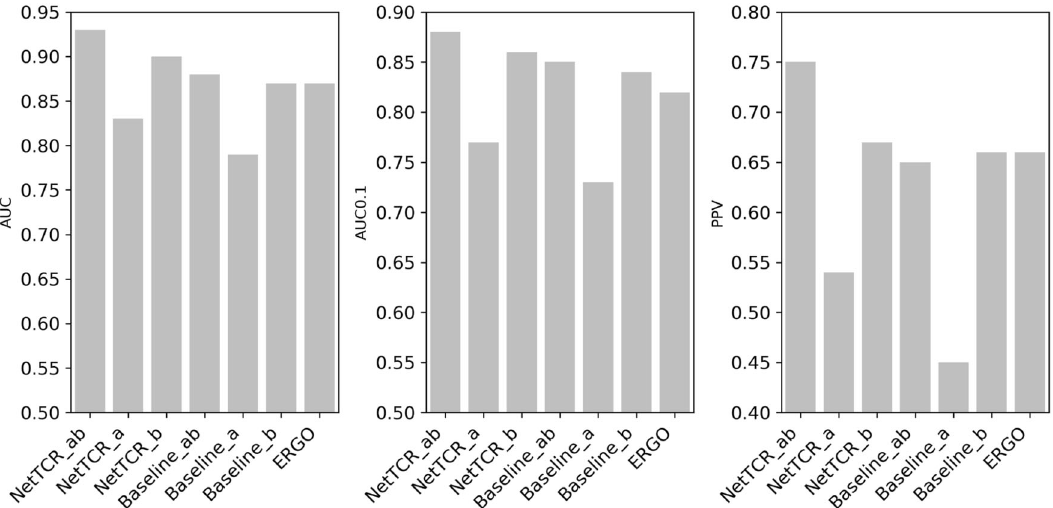
Fig. 8 Benchmark performance on in-house TCR data set. Methods included are NetTCR and baseline trained on paired CDR3 α – CDR3 β data (ab), CDR3 α (a), CDR3 β (b), and the LSTM-based ERGO trained on the VDJdb. Performance measures are (left) AUC, center (AUC 0.1), and right